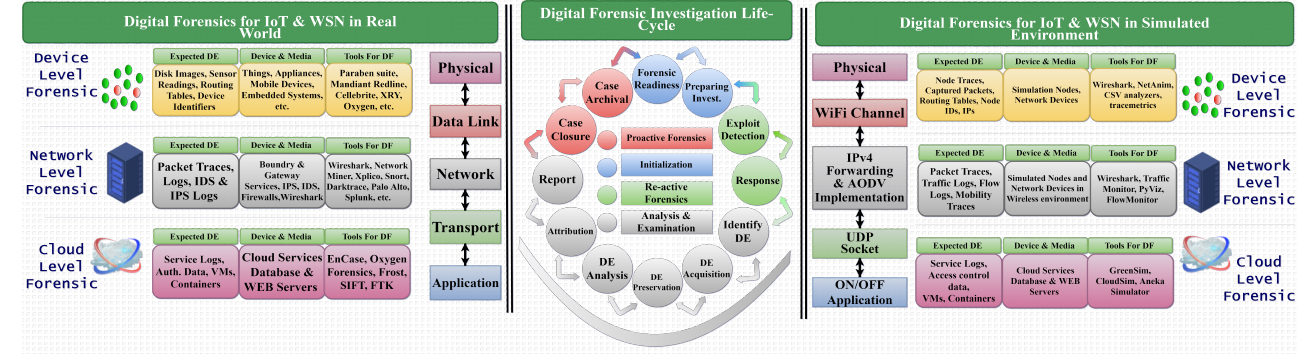
Figure 3. Analogy between real-life DF process and simulated